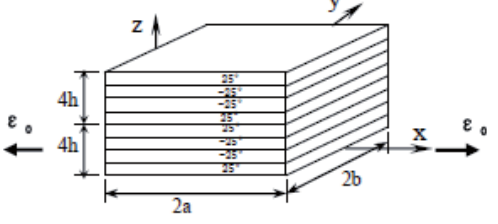
Fig. 1 Finite element model for the upper half of the [±25] s4 laminated rectangular plate subjected to a uniform axial strain (cid:3)